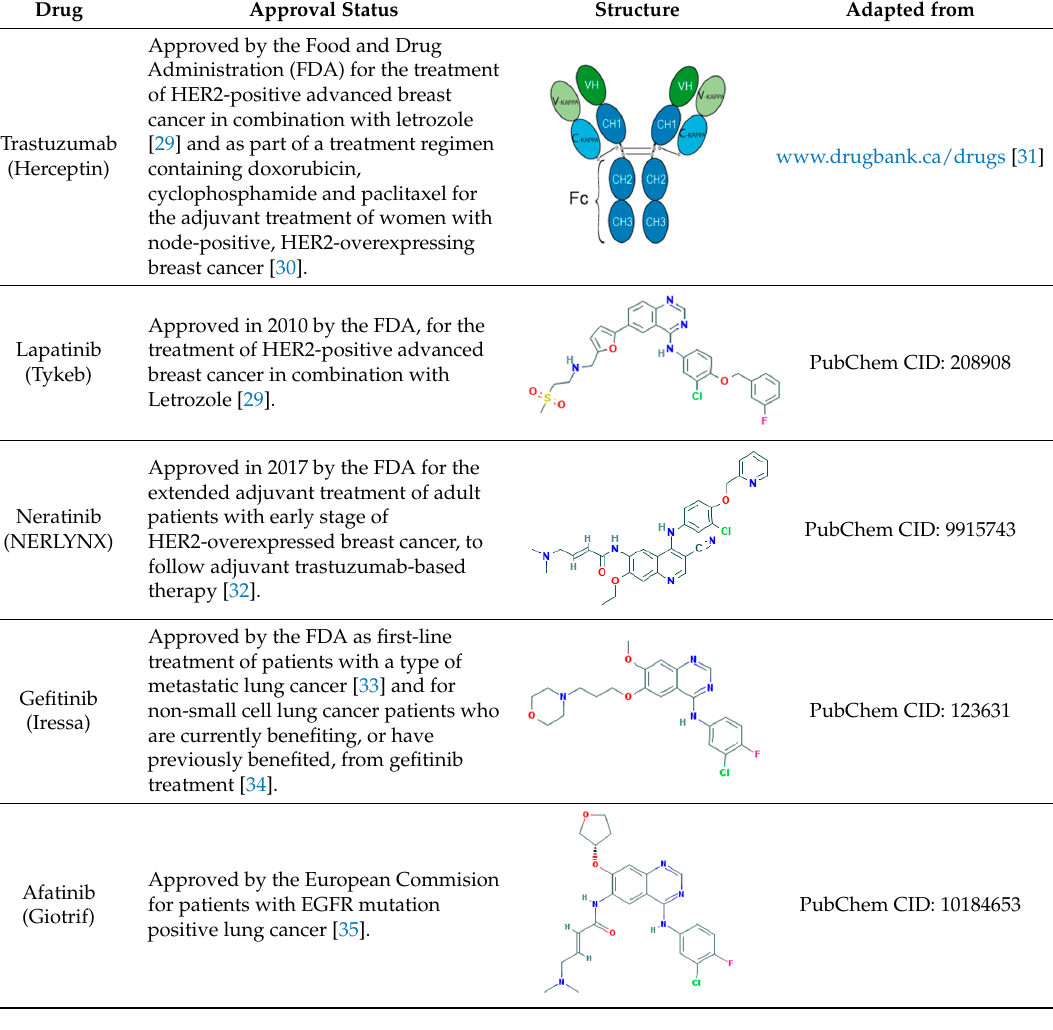
Table 2. Human epidermal growth factor receptor 2 (HER2) inhibitors.